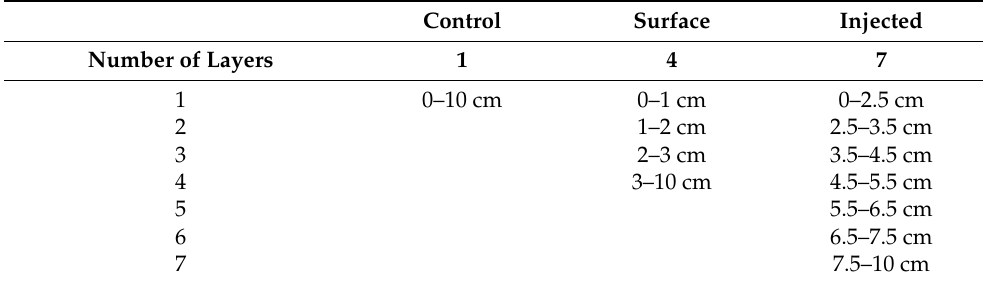
Table 2. Soil layer of destructive